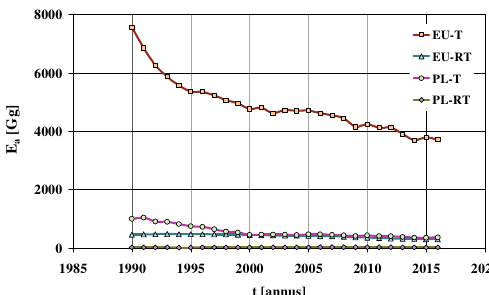
Fig. 4. Annual emission of total suspended particles: total in the Europe- an Union – EU-T, from motor vehicles in the European Union – EU-RT,